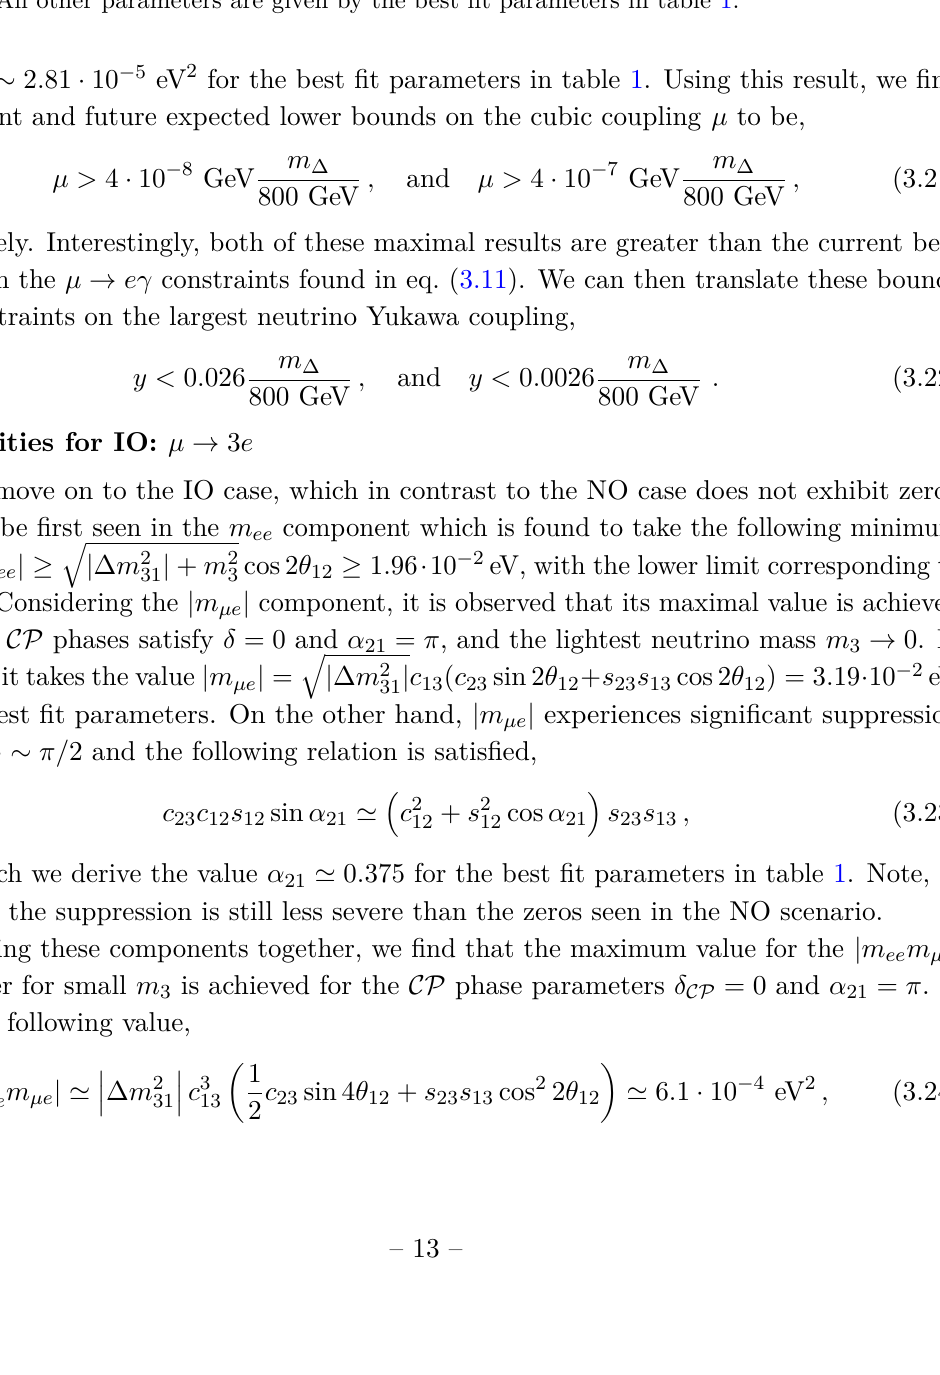
Figure 3 . Comparison of the maximum expected m ∆ probed by the upcoming µ → 3 e experiment, Mu3e [101] (Dashed), and the current constraints from the SINDRUM experiment [100] (Solid) for different sets of neutrino CP phases ( δ CP , α 21 , α 31 ) and varying lightest neutrino mass, in the IO scenario. All other parameters are given by the best fit parameters in table